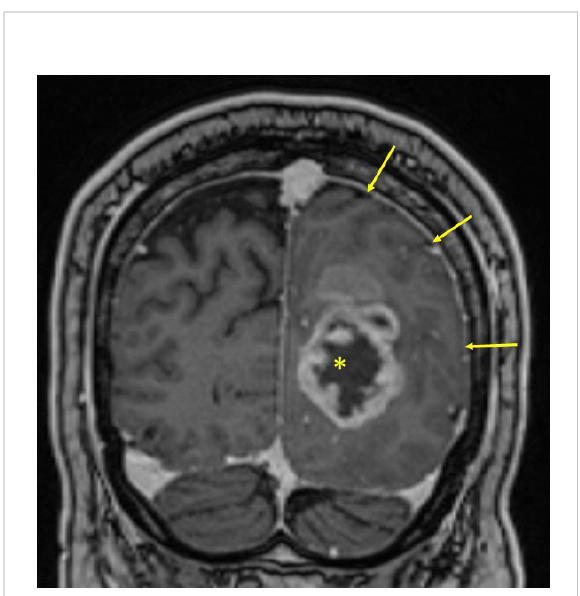
FIGURE 2 Solid glioblastoma in the left occipital lobe. Note how the tumor affects white matter (compare with contralateral side) and produces a mass effect with obliteration of the subarachnoidal spaces of the ipsilateral sulci (arrows). Centrally, this tumor has an area of necrosis (asterisk), which is not